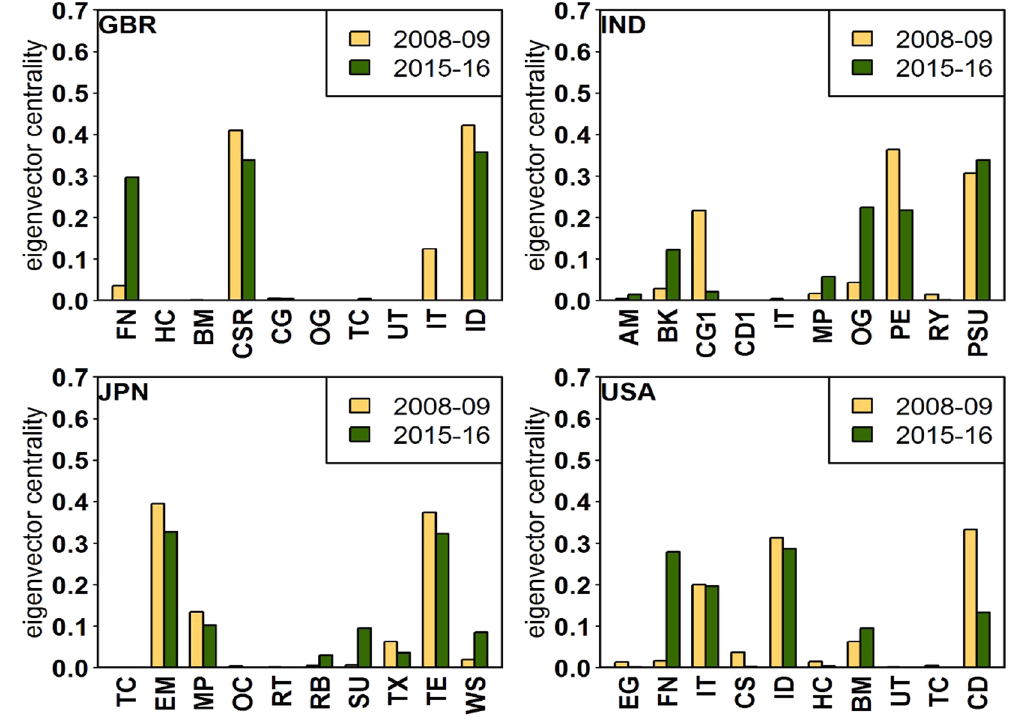
Figure 4. Sectoral dynamics and robustness: The comparison of the eigenvector centralities for the years 2008– 09 (light orange) and 2015–16 (dark green) for four countries. Upper Left : United Kingdom (GBR), Upper Right : India (IND), Lower Left : Japan (JPN), Lower Right : United States of America (USA).